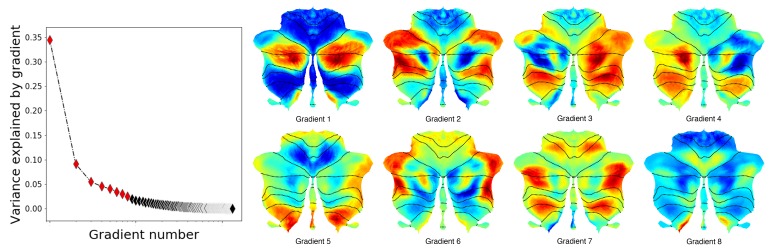
Additional gradients.Left: variance explained by each gradient; red diamonds correspond to the first eight gradients. Right: Gradients 1–8. Gradients 3 and 4 revealed laterality asymmetries in areas of nonmotor processing (Crus I, Crus II, VIIB and IX) but not in areas of motor processing (IV/V/VI and VIII). Notably, these asymmetries were constrained to areas of nonmotor processing (asymmetries are not present in motor lobules IV/V/VI and VIII). Consistent with this observation, left/right asymmetries in cerebellar processing have been described in multiple nonmotor tasks (Hu et al., 2008) but not in motor processing. One extreme of Gradient 5, 7 and 8 included unilateral or bilateral aspects of lobule IX (extreme shown in red for Gradient 5 and 8 and in blue for Gradient 7). Gradient 6 included at one extreme anterior portions of Crus I and Crus II. The other end included medial Crus I and Crus II as well medial regions of lobule VIIB. The added percentage of variability explained by each following gradient was minimal.